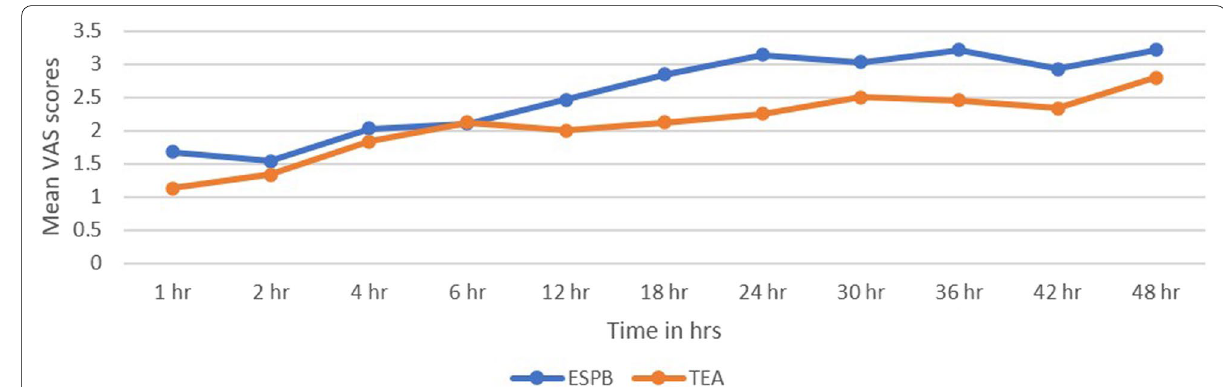
Fig. 1 Line diagram showing comparison of mean VAS scores at various time frames over 48 h between group